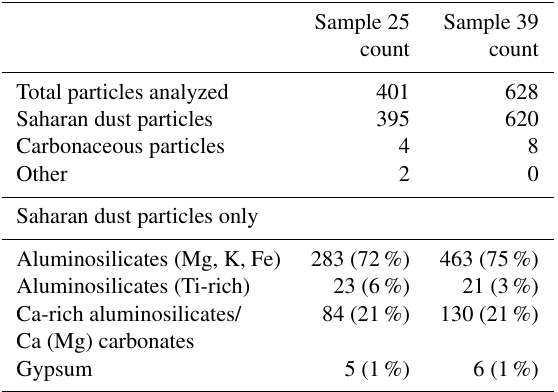
Figure 7. The Skywalker UAS with the single-sample aerosol col- lector (green rectangle; photograph by Christos Keleshis). Table 3. Average chemical composition of randomly selected single aerosol particles analyzed by electron microscopy of sample 25 (9 April) and sample 39 (21